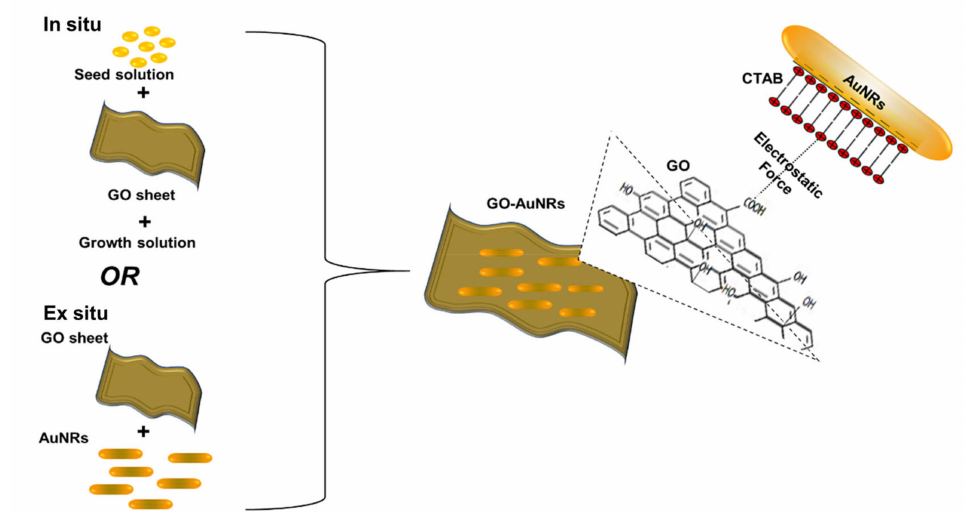
Figure 4. Methods of obtaining GO-coated AuNRs (GO–AuNRs) and the electrostatic bond between AuNRs and